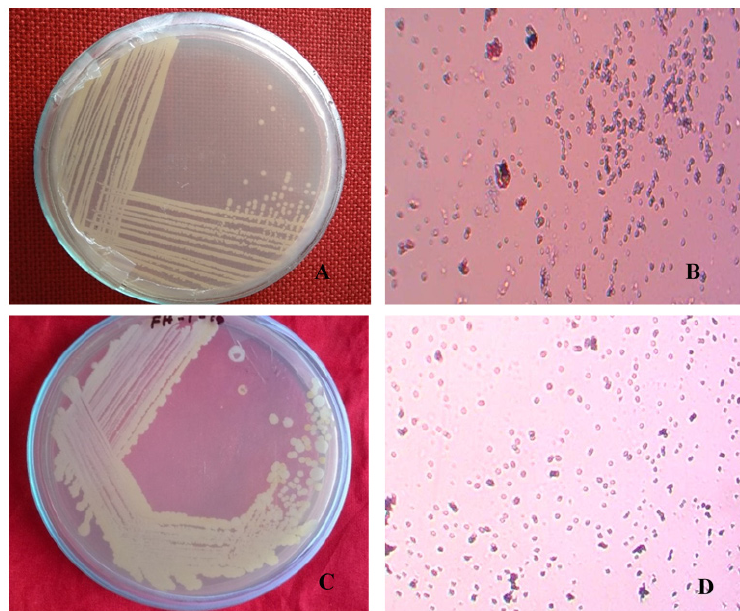
Figure 1. Naturally infected postharvest sweet orange fruit showing pure culture and morphological phenotypes. Isolated bacterial pure colony ( A ) BS1 and ( C ) BS2; images taken after 18 hours of incubation at 37°C on LB agar. Gram staining of isolated bacterial pure colony ( B ) BS1 and ( D ) BS2; images taken under the light microscope at 100X magnification, showing as Gram negative.